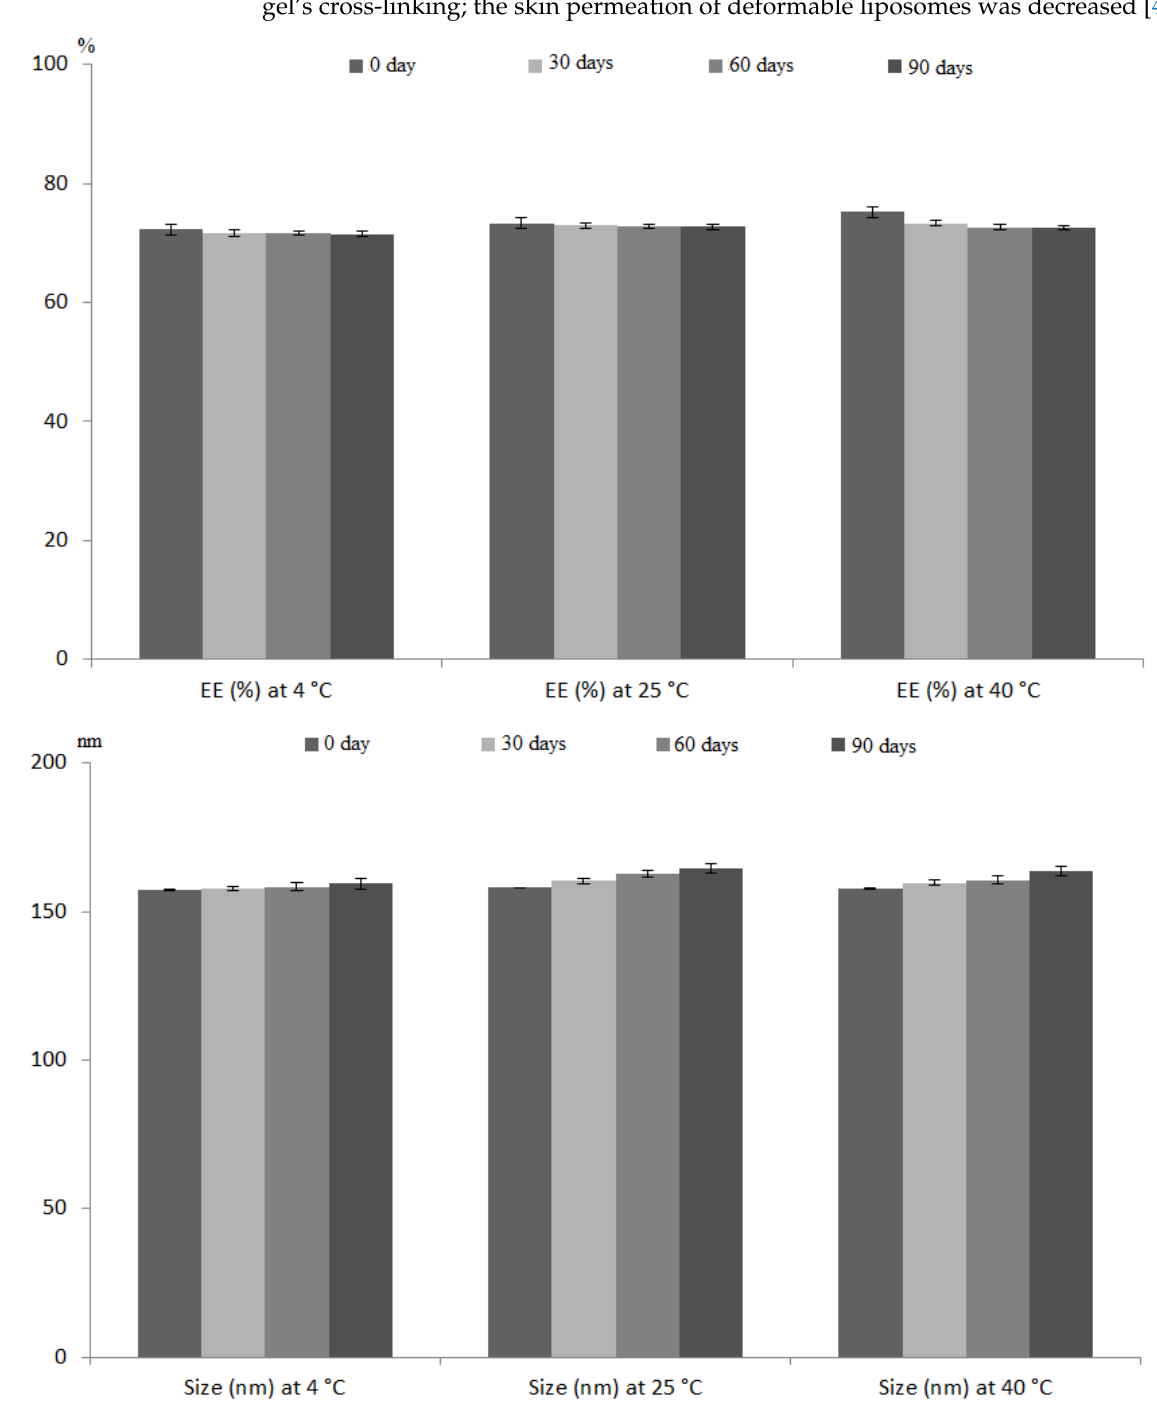
Figure 5. The effect of storage on the % EE and particle size of the optimum RLDL formulation at 4 °C, 25 °C and 40 °C. Each value was the mean ± standard deviation of measurements from three samples.